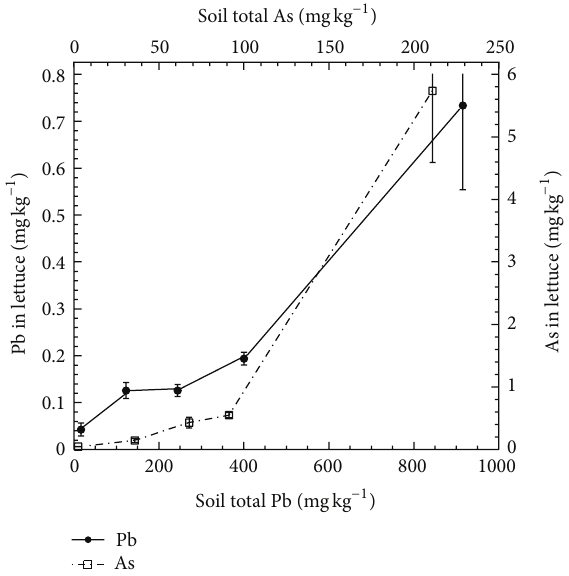
Figure 1: Pb and As concentrations (mgkg −1 d.w.) in lettuce grown on orchard soils containing a range of Pb and As. Error bars in this figure and subsequent figures depict plus and minus one standard deviation unit.